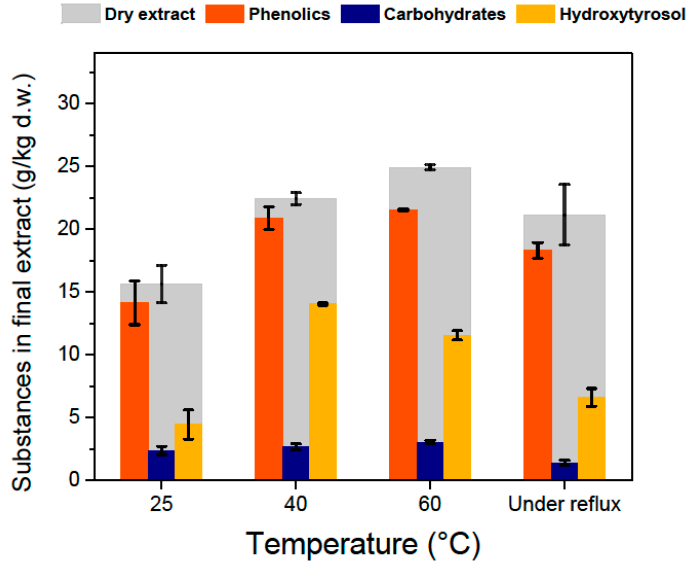
Figure 8. Effect of temperature during solid–liquid extraction, with 70% ( v / v ) ethanol, in the substance profile in the final extract. Hydrolysis was performed with 1 M HCl and boiling under reflux for 15 min.